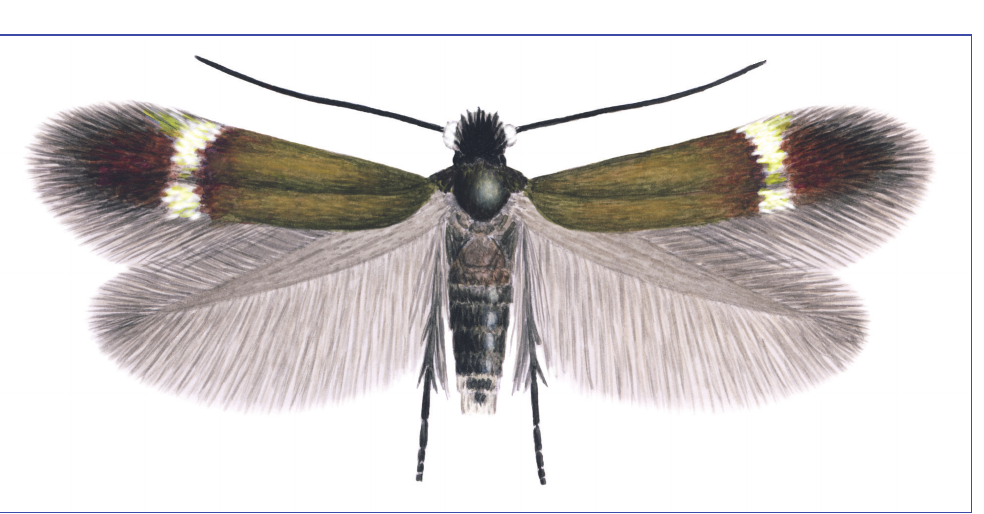
Figure 1. Stigmella tatrica sp. n., male, holotype, wingspan 4.0